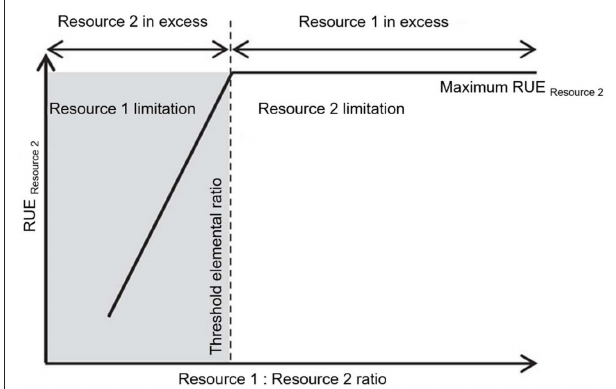
FIGURE 3 | Conceptual figure modified after (Mooshammer et al., 2014). The relation between threshold elemental ratio (TER) and resource use efficiency (RUE) depending on the available resource ratio. The TER is defined as the optimal resource elemental ratio for consumer growth (Urabe and Watanabe, 1992 ). The TER marks the ratio of two resources above which a maximal RUE for one resource is reached (here resource 2) as this resource becomes limiting. While the limiting resource is expected to be used for growth, the resource in excess must be disposed